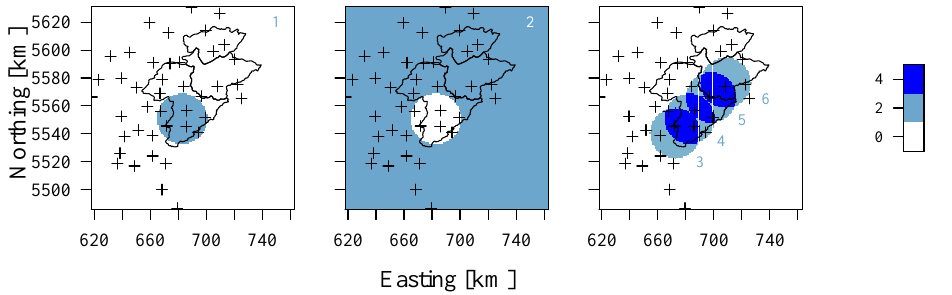
Fig. 7. Sensitivity analysis. Circular-shaped rainfall events consisting of six rainfall fields 1–6. Raster resolution is 1km × 1 km. Plusses show the rain gauges and black line delineates the Upper Ourthe, Ambl`eve and Vesdre catchments.